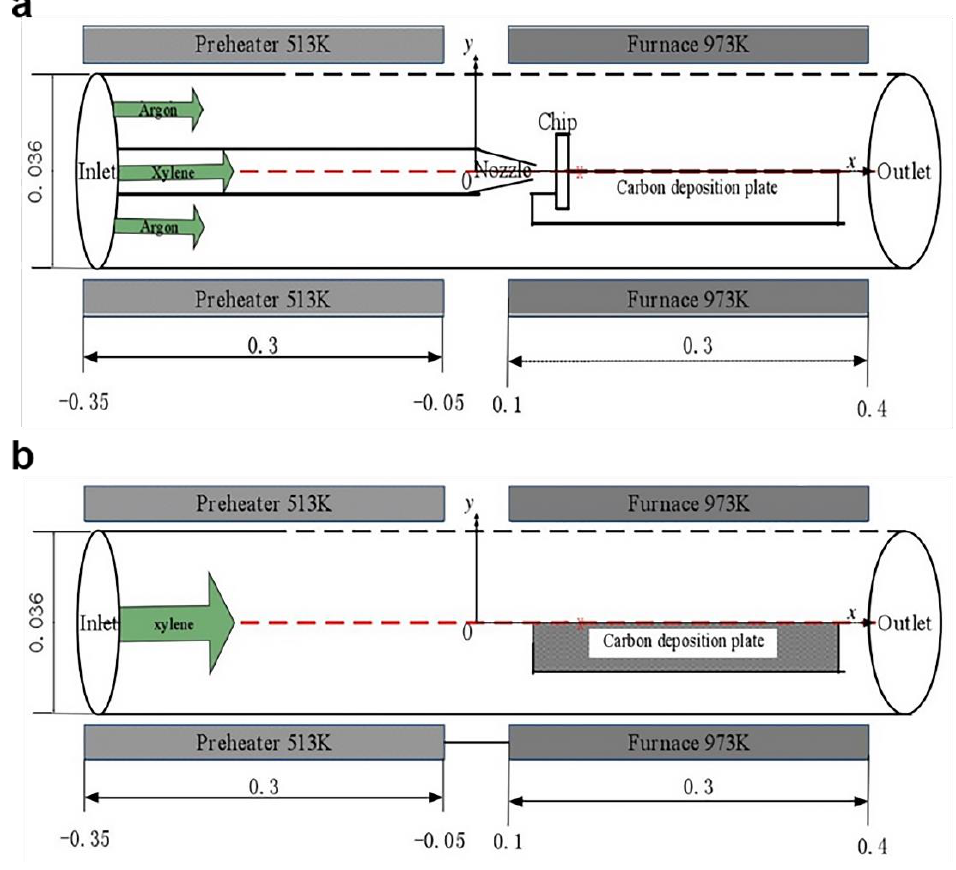
Figure 23. Schematics of chemical vapor deposition (CVD) reactor with nozzle ( a ) and CVD reactor without a nozzle ( b ) [193].